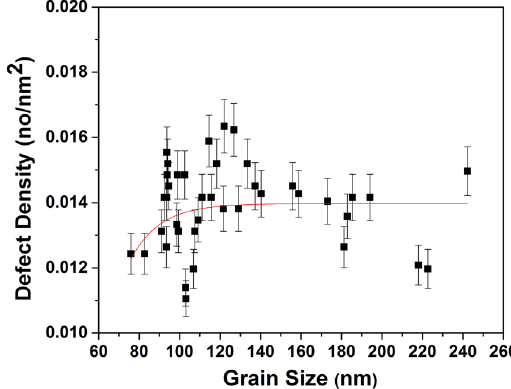
Figure 4. Loop areal density (loops/nm 2 ) vs grain size at the end dose (2.87 × 10 21 ion.m − 2 ) of irradiated